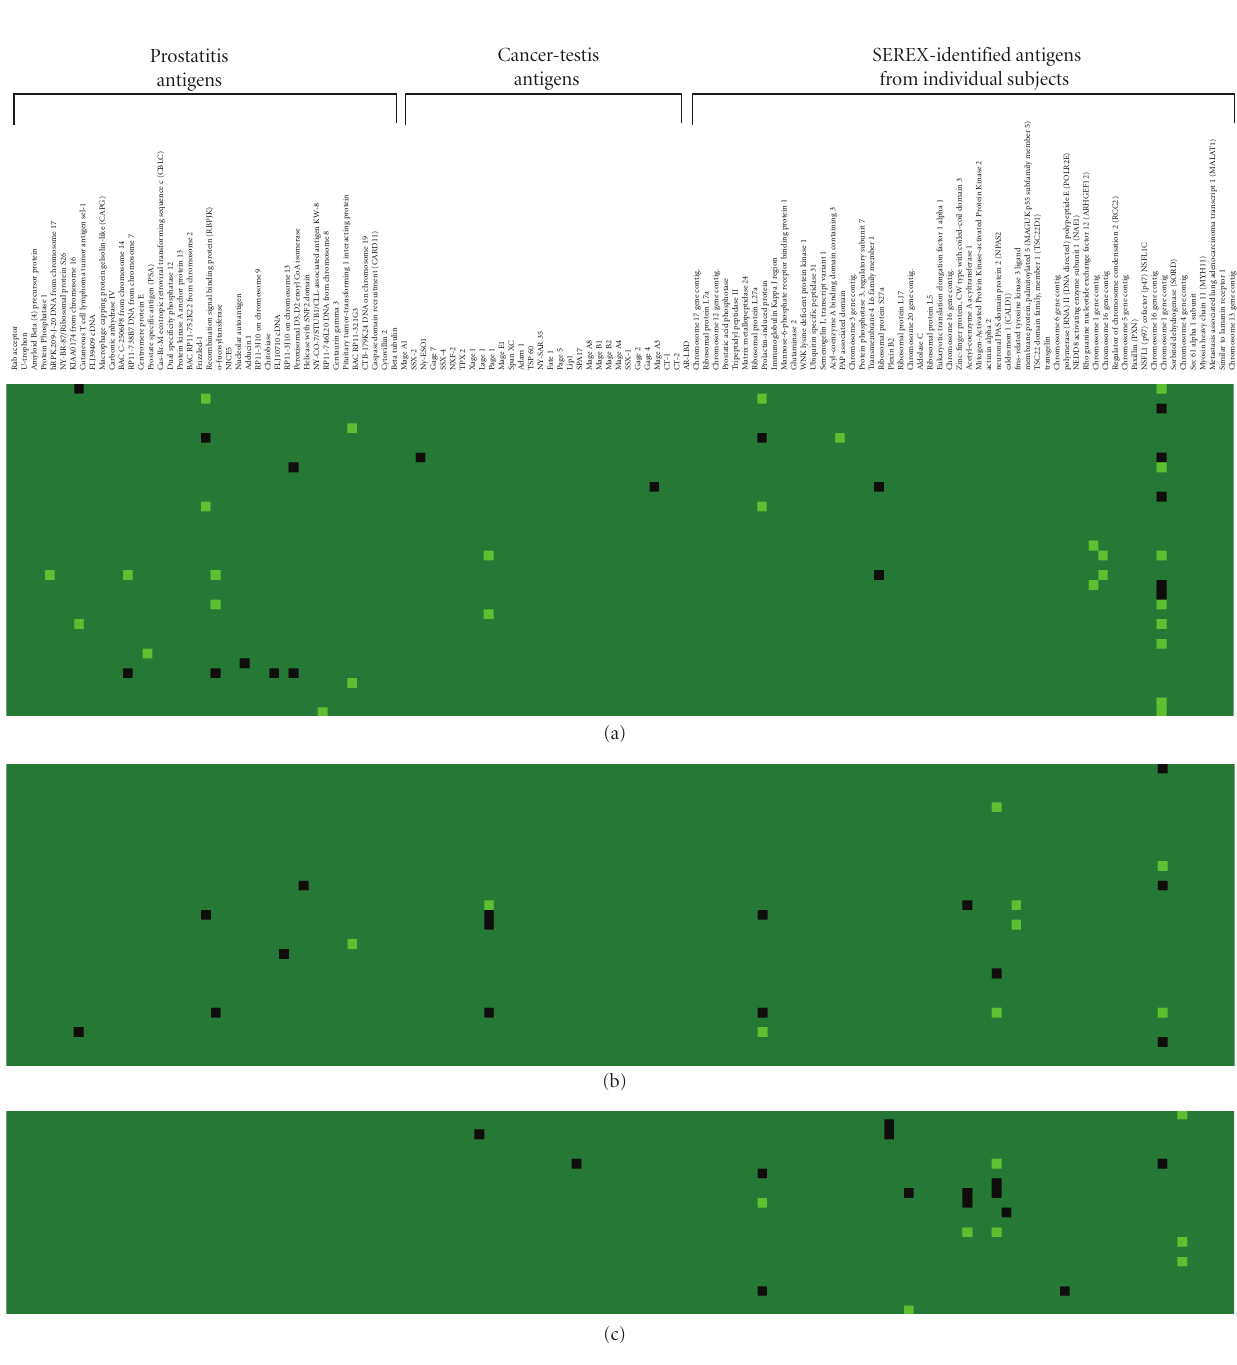
Figure 2: IgG responses to prostate-associated antigens are elicited following prostate cancer-directed therapies. Sera from patients pretreatment and three months following treatment with androgen deprivation ((a), n = 34), a PSA-targeted viral vaccine ((b), n = 31), or a PAP-targeted DNA vaccine ((c), n = 21) were evaluated for IgG responses to 126 prostate-associated antigens. Antigens (detailed in Supplemental table 1) are grouped according to the original studies from which they were derived (prostatitis antigens, cancer-testis antigens, or antigens detected by SEREX from individual subjects), and IgG responses were scored as previously described [15]. Shown is a heatmap representing gain of response pretreatment to posttreatment (light green), loss of response following treatment (black), or no change in response (dark green) for all subjects (in rows) and all antigens (in